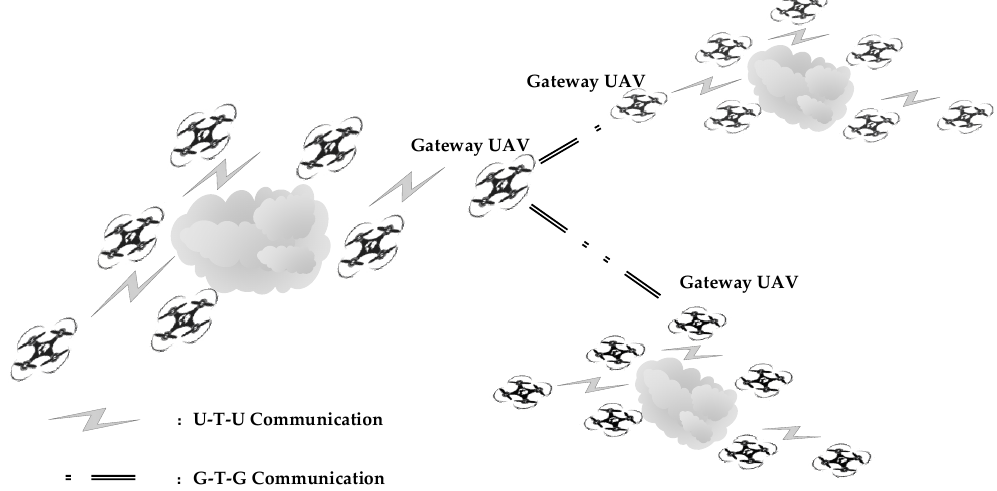
Figure 8. Multilevel Hierarchical Routing in a UAV swarm Ad hoc network.